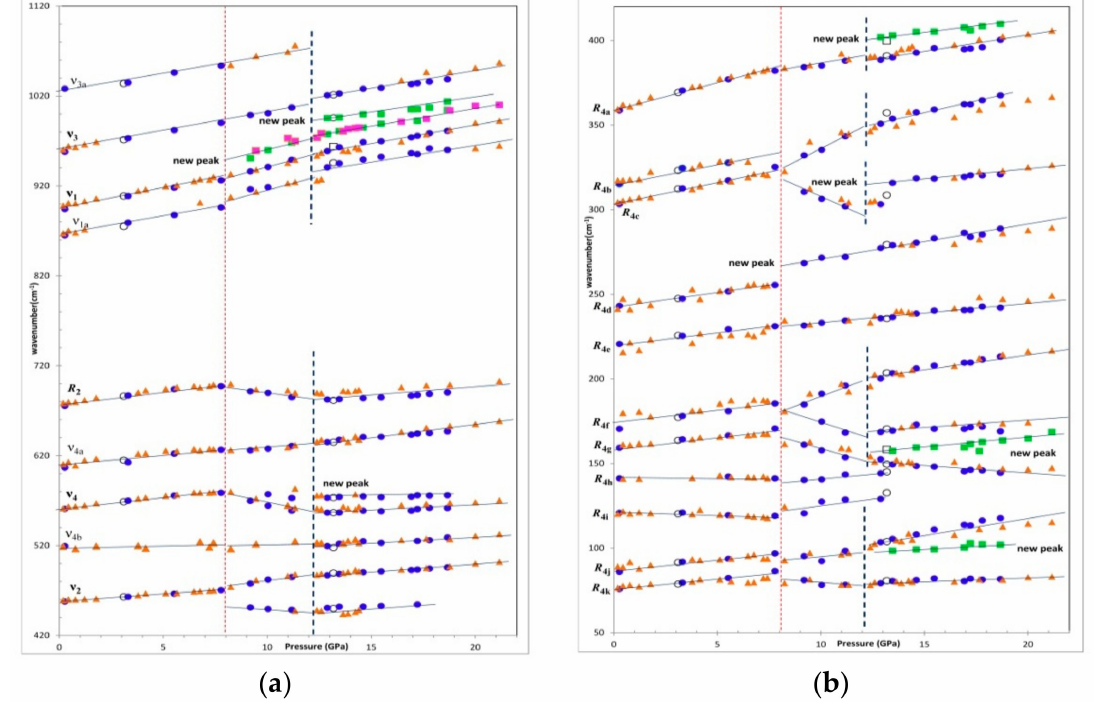
Figure 2. The variations in the wavenumber for each Raman mode of scottyite with pressure. ( a ) Wavenumber range: 420–1120 cm − 1 ; ( b ) wavenumber range: 50–420 cm − 1 . Data for loading process are shown as solid symbols (two runs: red triangle and blue round shape) and those for unloading process as open symbols. The dotted line means the discontinuity of the slope on each Raman mode. There are some new peaks (green/pink square shape) during the loading process which are on ν 1 , R 4 d modes between 8 and 12 GPa and R 4 a , R 4 c , R 4 j modes above 12 GPa. The solid lines are the eyeball linear fit of the